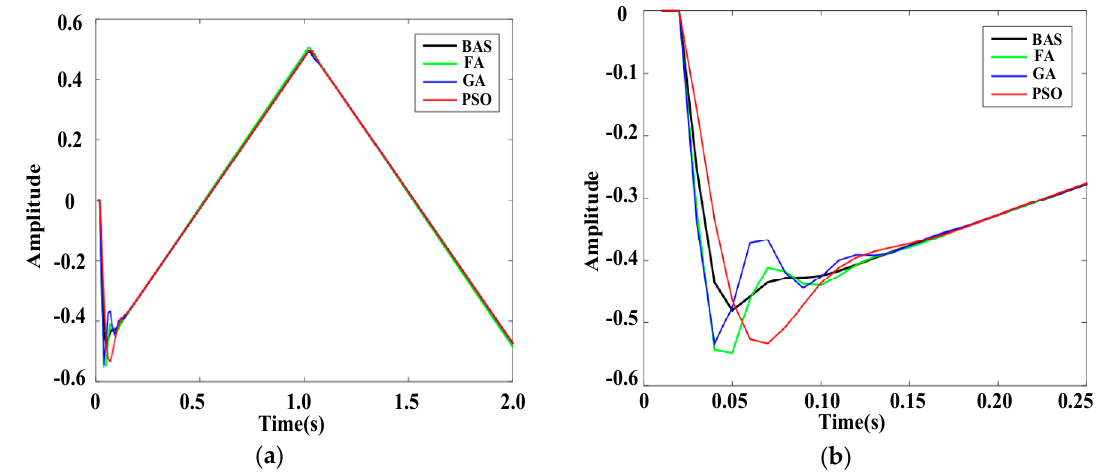
Figure 7. Response curves of the triangular wave signal. ( a ) Whole response curves. ( b ) Local amplification curves.